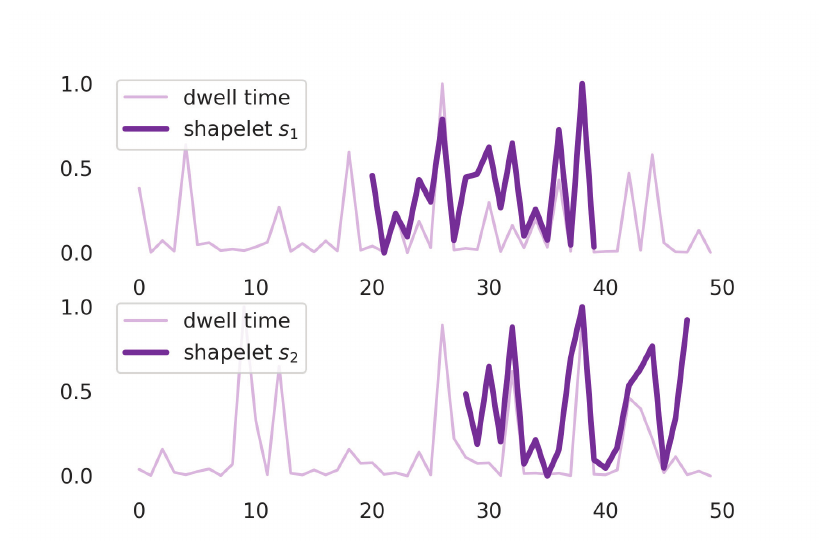
Fig 3. Two exemplary samples of dwell time series of length N = 50 obtained from the analysis of patch–clamp recordings corresponding to [Nar] = 0 μM (upper figure) and [Nar] = 10 μM (lower figure) and the same mebrane potential U = 60 mV. Both sequences are presented alongside with the shapelets s 1 , s 2 found by the machine learning m algorithm of length 20 which best match the shape of